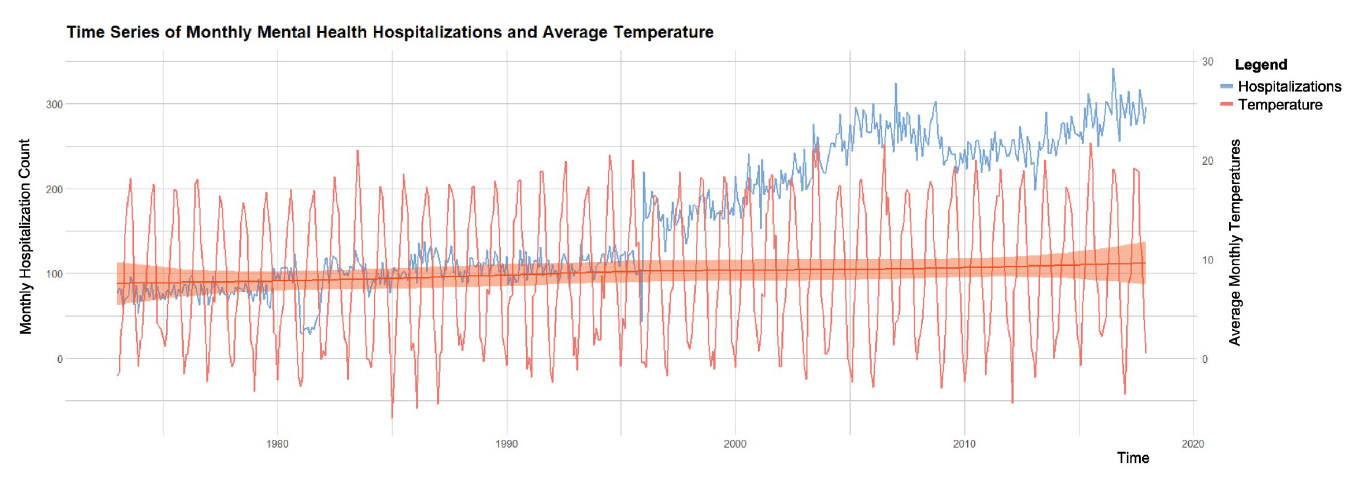
Fig 2. Temporal evolution of the hospitalizations due to mental disorders and mean temperature across the 45-year study period (1973–2017).